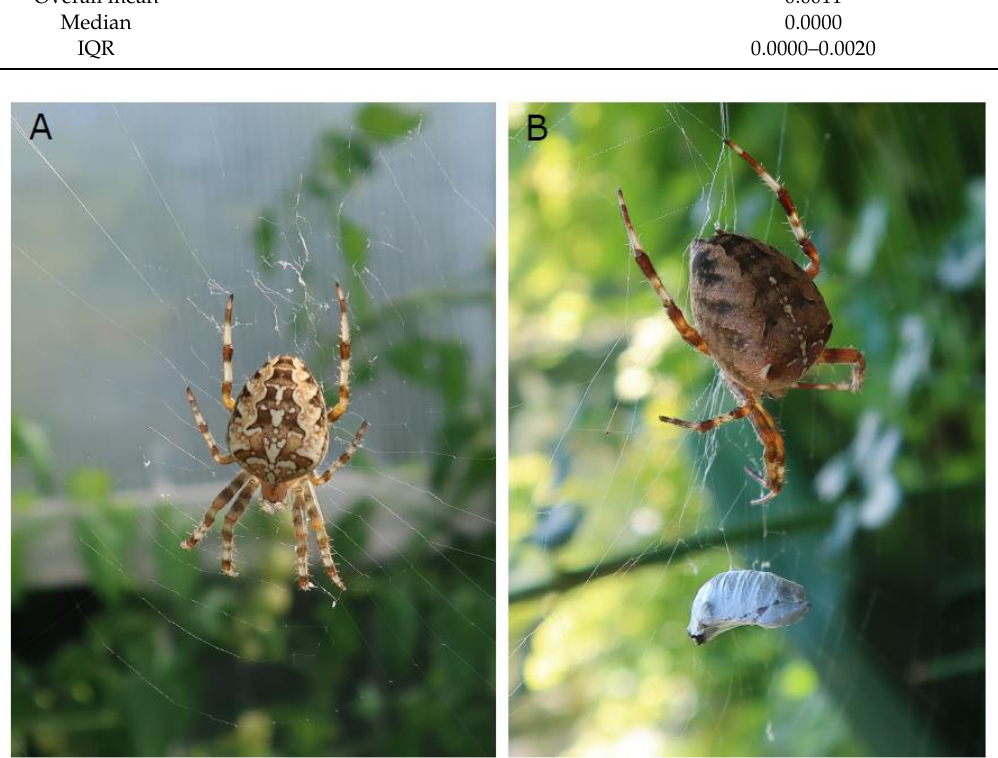
Figure 2. ( A , B ) Adult female Araneus diadematus in web in a garden in Flawil, northeastern Switzerland (photo by Rätus Fischer).